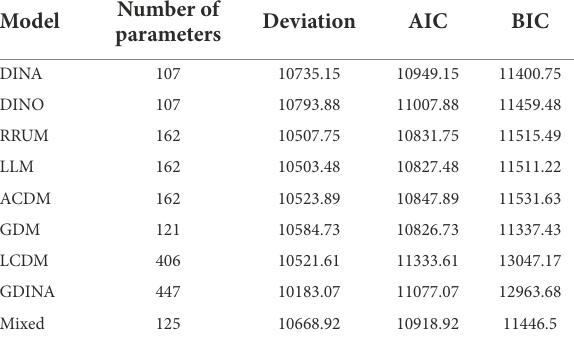
TABLE 4 Statistical comparison of parameters in different